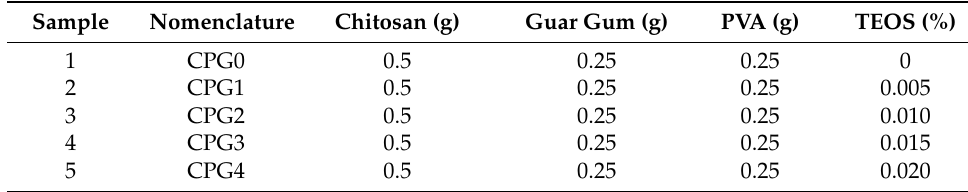
Table 1. The formulation used in the preparation of CPG